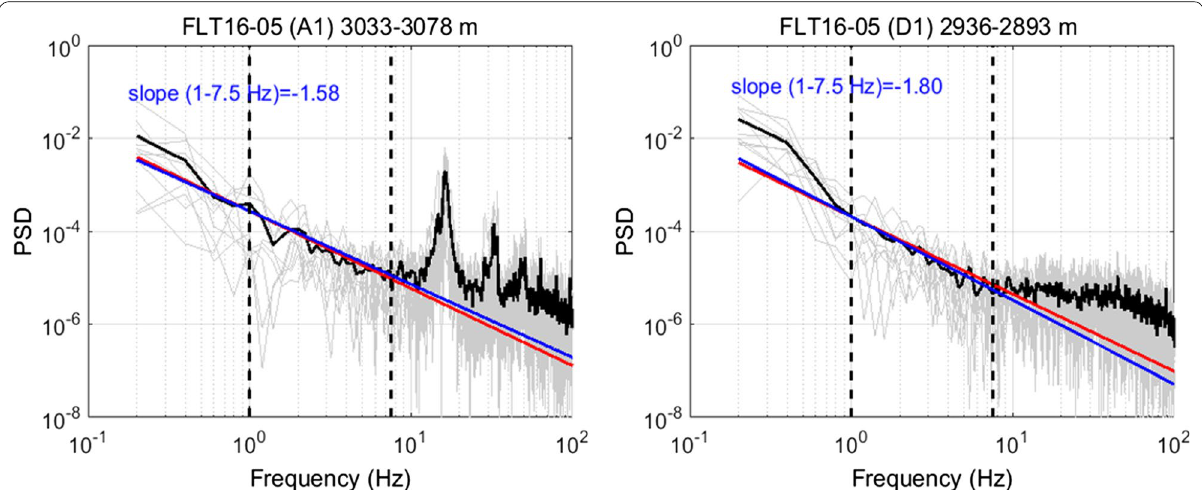
Fig. 4 Example of frequency spectra of U up to 100 Hz during the ascent (A1) (left) and descent (D1) (right) of FLT16-05. The black lines show spectra after averaging the 10 spectra in gray lines. The red lines show the between 1.0 and 7.5